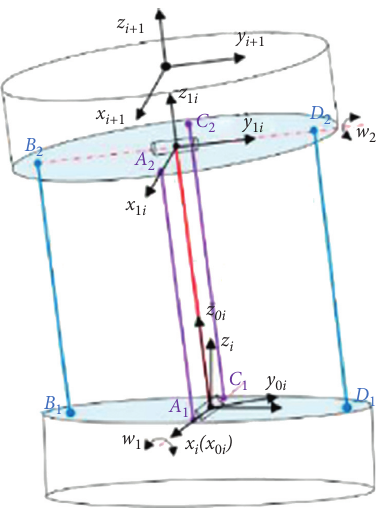
Figure 6: Kinematics coordinate system of the single